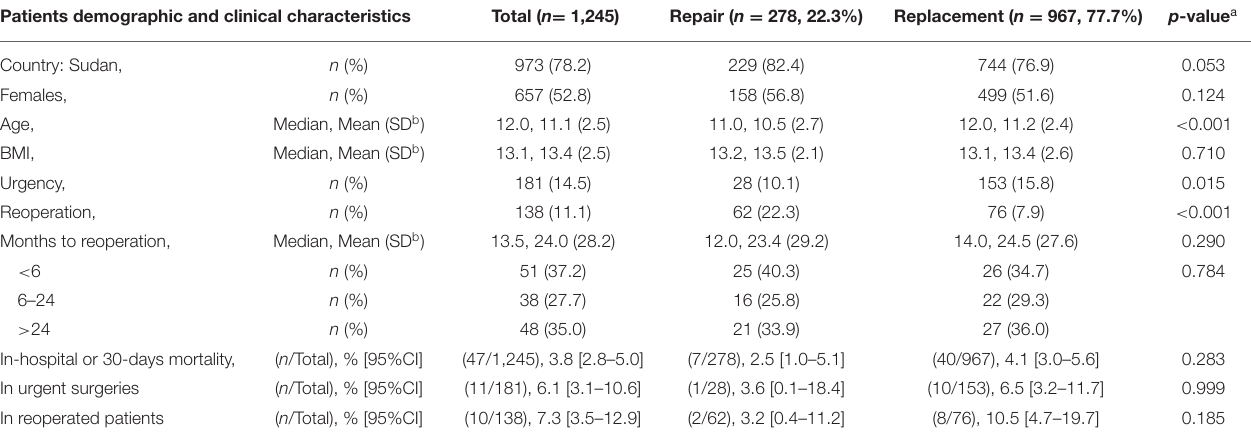
TABLE 2 | Main characteristics and clinical outcomes of the overall sample of 1,245MV or (MV + TV and/or AV) children, and for repair and replacement surgery separately. Patients demographic and clinical